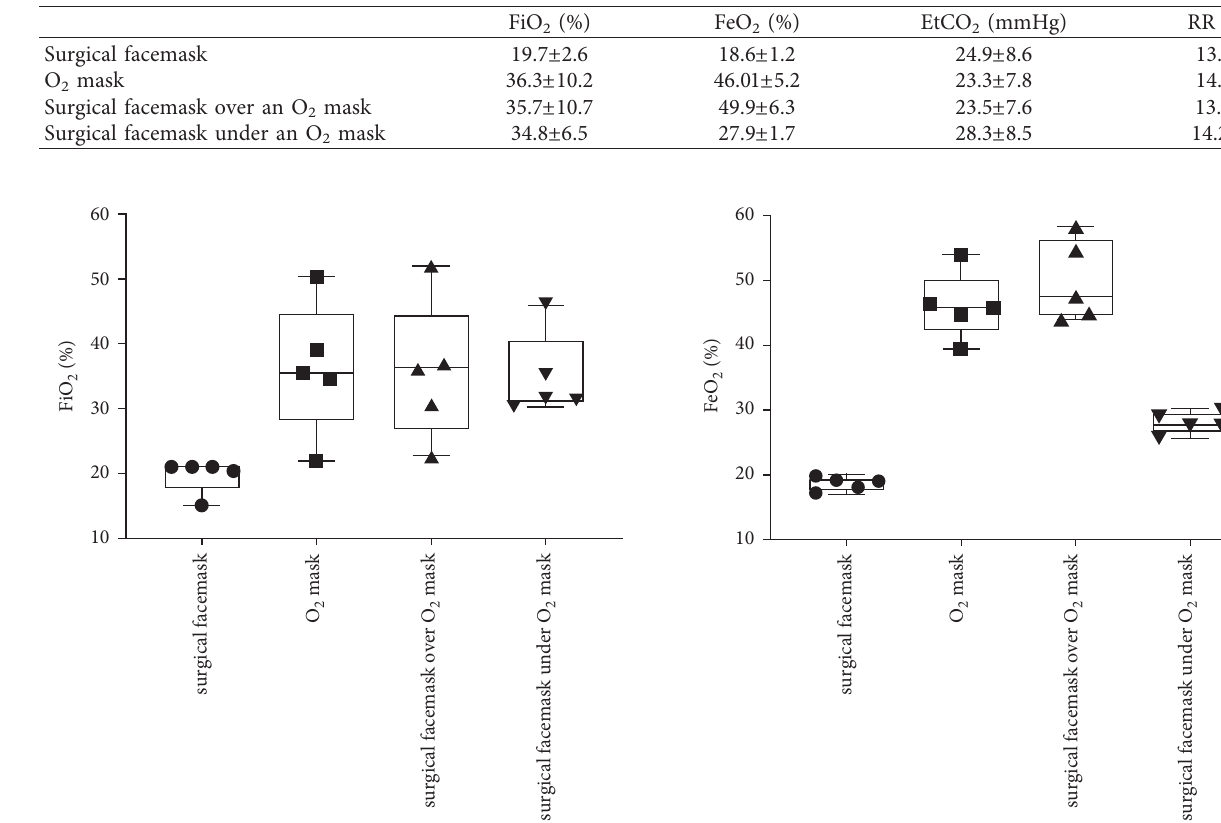
Table 1: Table of measured FiO 2 , FeO 2 , EtCO 2 , and respiratory rate with a surgical facemask only, an O 2 mask only, a surgical facemask over an O 2 mask, and a surgical facemask under an O 2 mask. Values are reported at mean ± standard deviation.